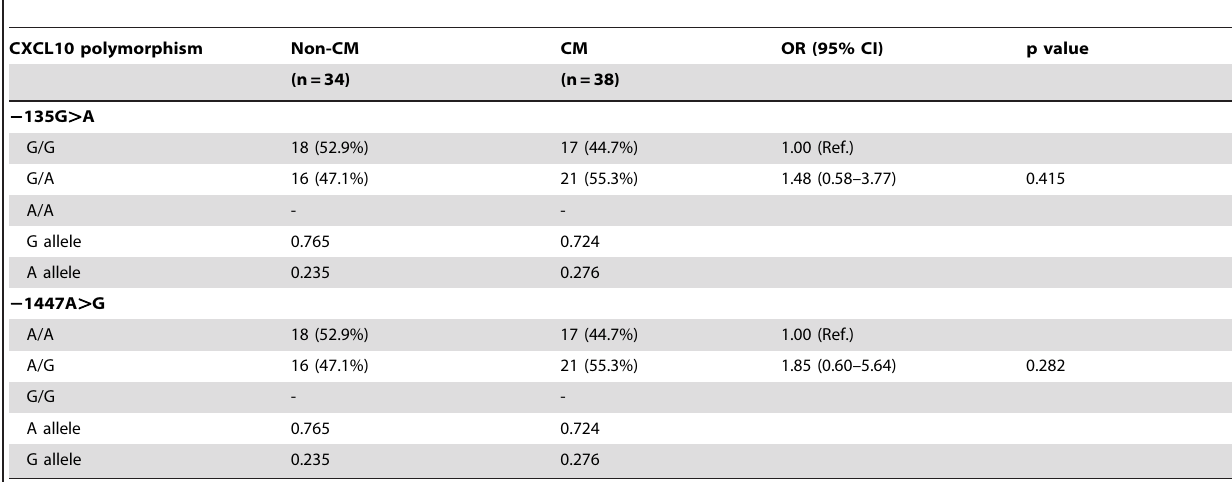
Table 5. Stratification analysis of female gender on association between CXCL10 promoter polymorphisms ( 2 135G . A and 2 1447A . G) and cerebral malaria.